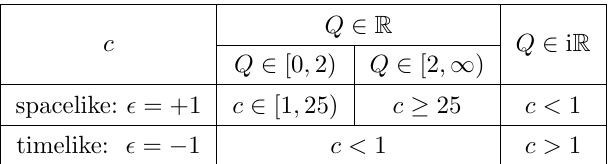
Table 1 . Range of real values of the Liouville (or Coulomb gas) central charge depending on the parameters Q and (cid:15) . For the spacelike case (cid:15) = 1, the two di(cid:11)erent ranges Q 2 [0 ; 2) and Q (cid:21) 2 correspond to b 2 e i R and b 2 R respectively. What is typically known as the spacelike Liouville theory corresponds to the regime (cid:15) = 1 and Q (cid:21) 2, and the range typically known as the timelike Liouville theory corresponds to (cid:15) = (cid:0) 1 and Q 2 R